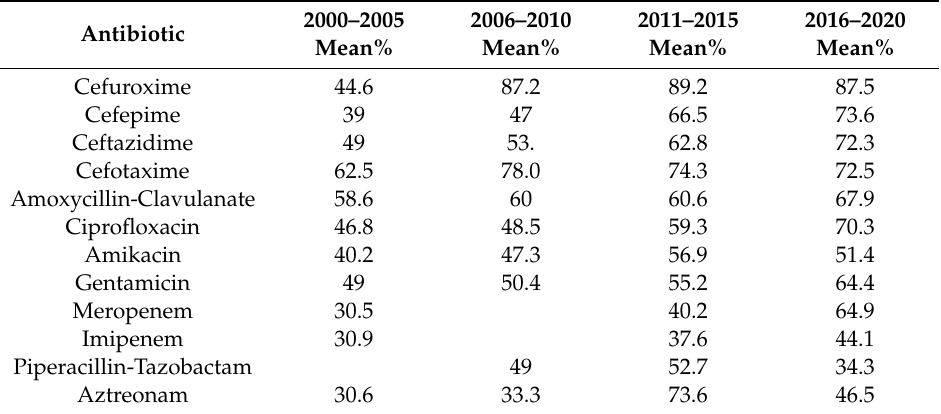
Table 4. Antibiotic resistance in E. coli and ESKAPE pathogens during